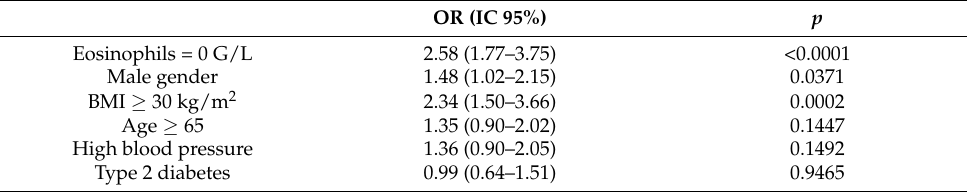
Table 5. Multivariate analysis of factors associated with a composite poor